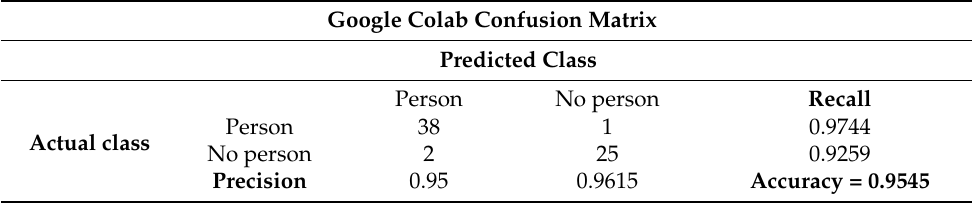
Table 8. Accuracy of the person detector with Google Colab.